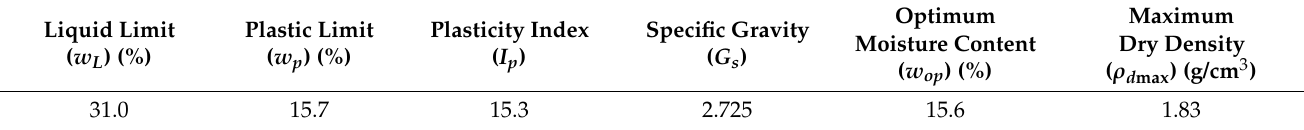
Figure 4. Grain size distribution curve of the clay soil.